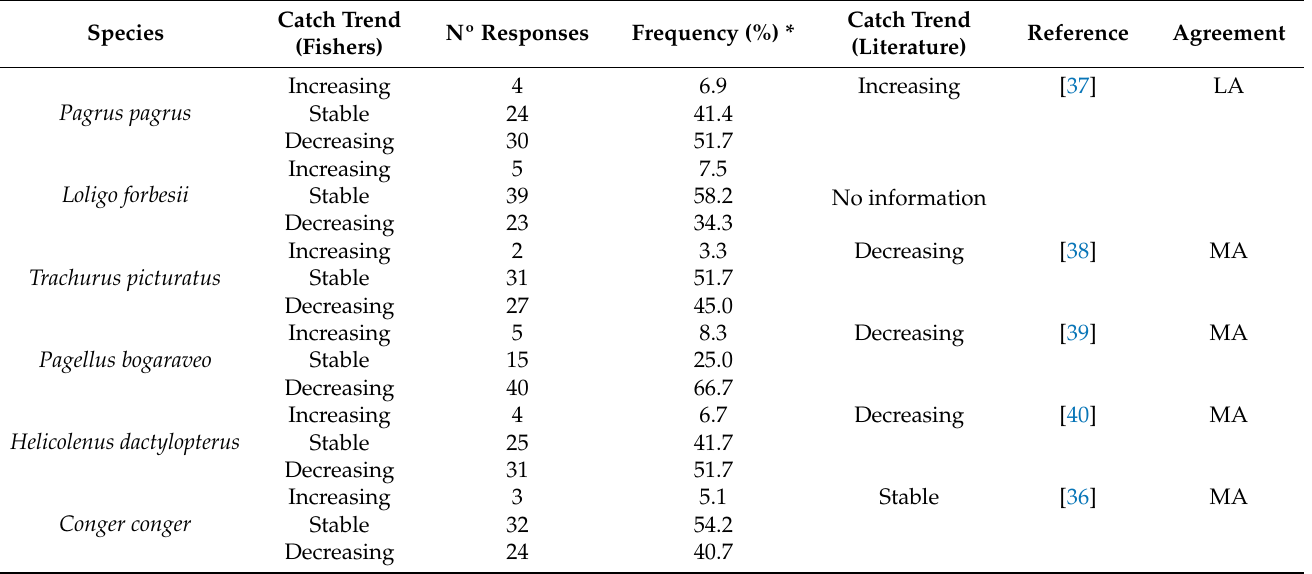
Table 4. Catch trend of the six species studied in the Azores according to fishers’ experiential knowl- edge, obtained from scientific literature (reported abundance index estimates), and the agreement between these two sources of information. LA = low agreement; MA = medium agreement. Nº responses = number of fishers who answered this